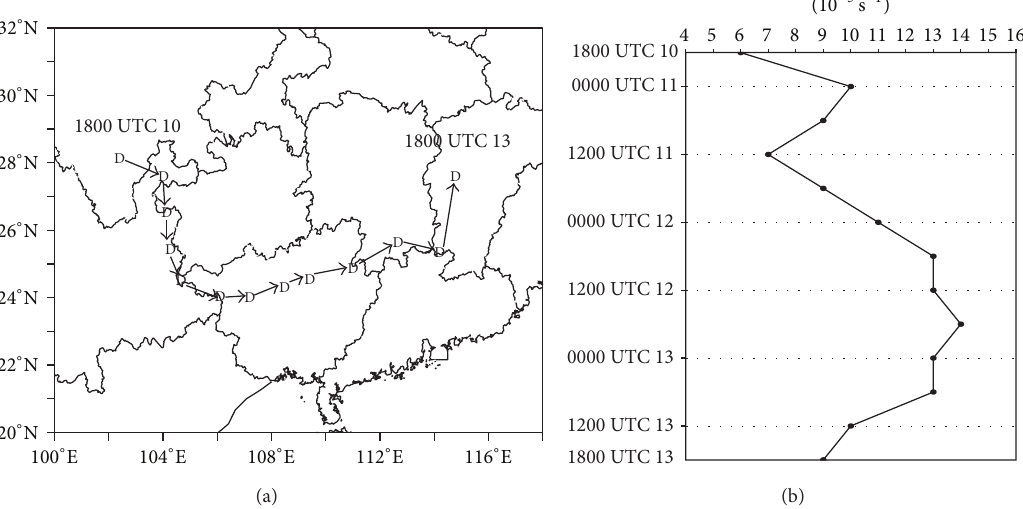
Figure 1: The SWV (a) movement pathway (dark line with arrows) and (b) center vorticity variation at 700 hPa tracked every 6 hours from 18 UTC June 10, 2008 to 18 UTC June 13, 2008 (the unit of vorticity is 10 −5 s −1 ); D indicating the SWV centers.